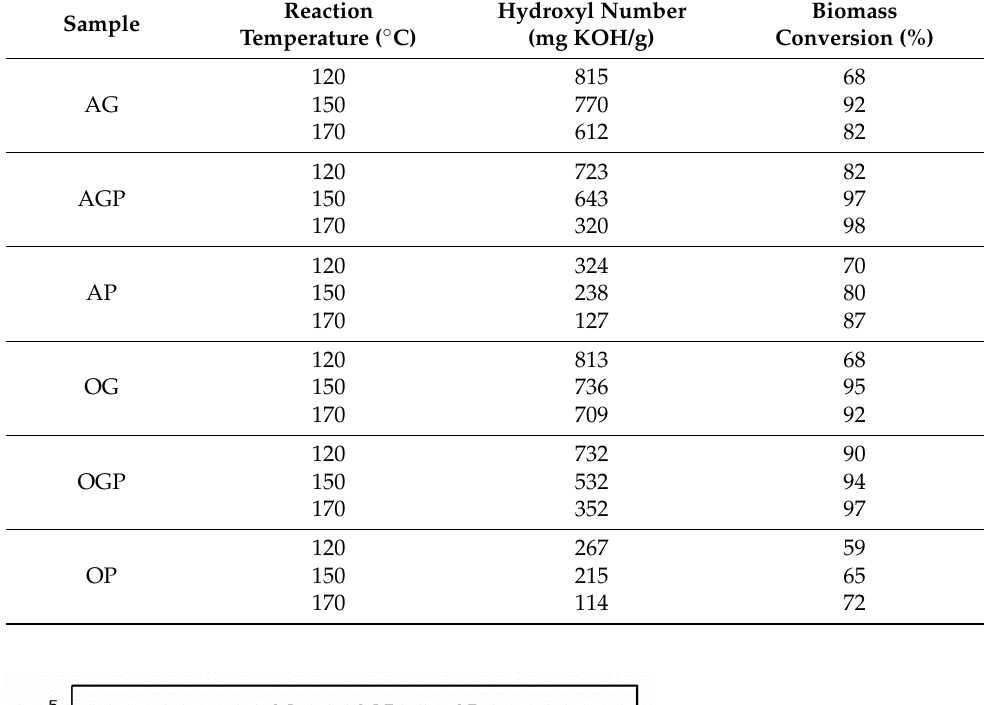
Table 3. The hydroxyl value and biomass conversion of liquefied bio-polyols.